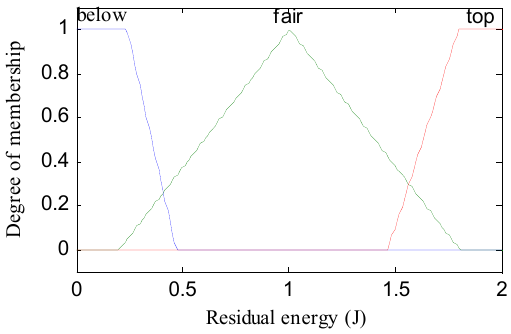
Figure 1. Membership function of RE (residual energy).